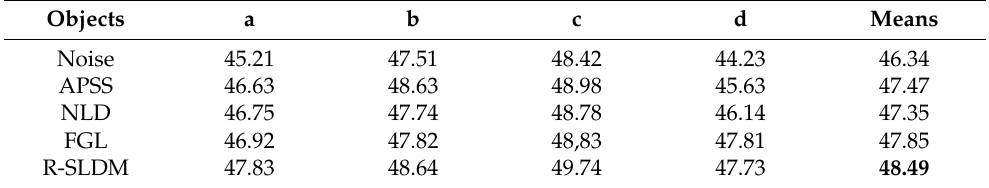
Table 5. MSE (×10 − 3 ) of different denoising algorithms for four objects.